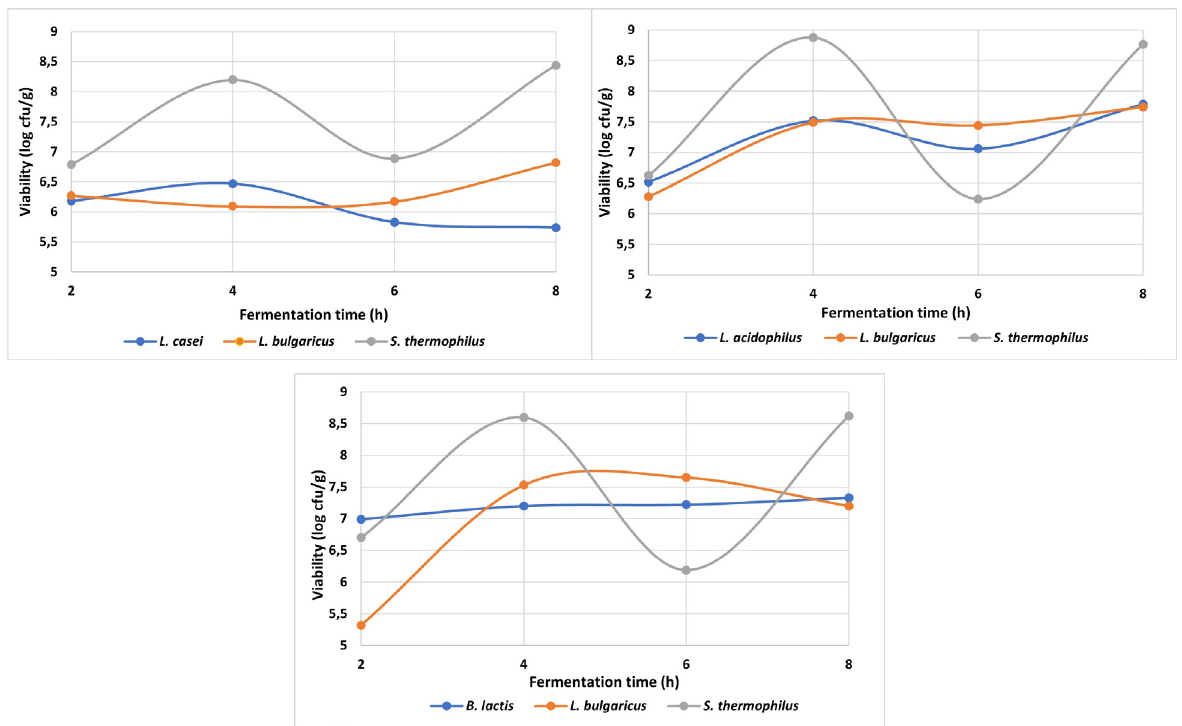
Figure 4a. L. casei , S. thermophilus and L. bulgaricus counts in LCY sample during the fermentation. Figure 4b. L. acidophilus , S. thermophilus and L. bulgaricus counts in LAY sample during the fermentation. Figure 4c. B. lactis , S. thermophilus and L. bulgaricus counts in BLY sample during the